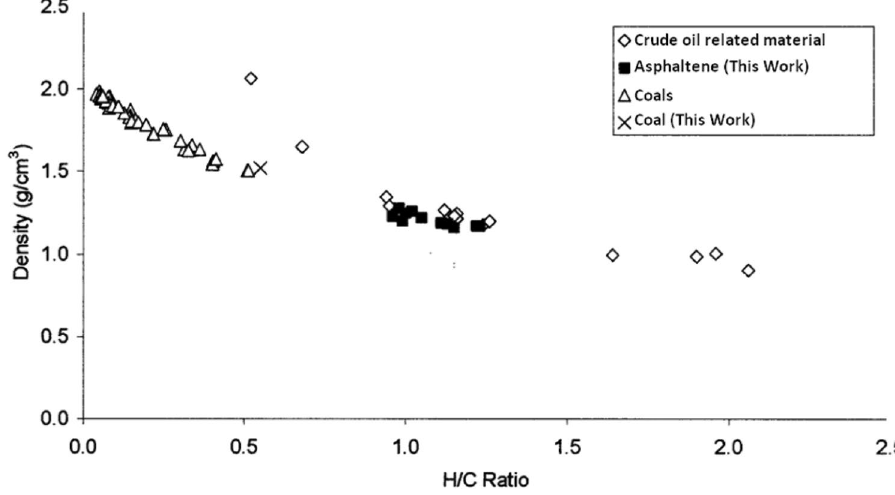
Fig. 4 Obtained experimental densities and similar sample results